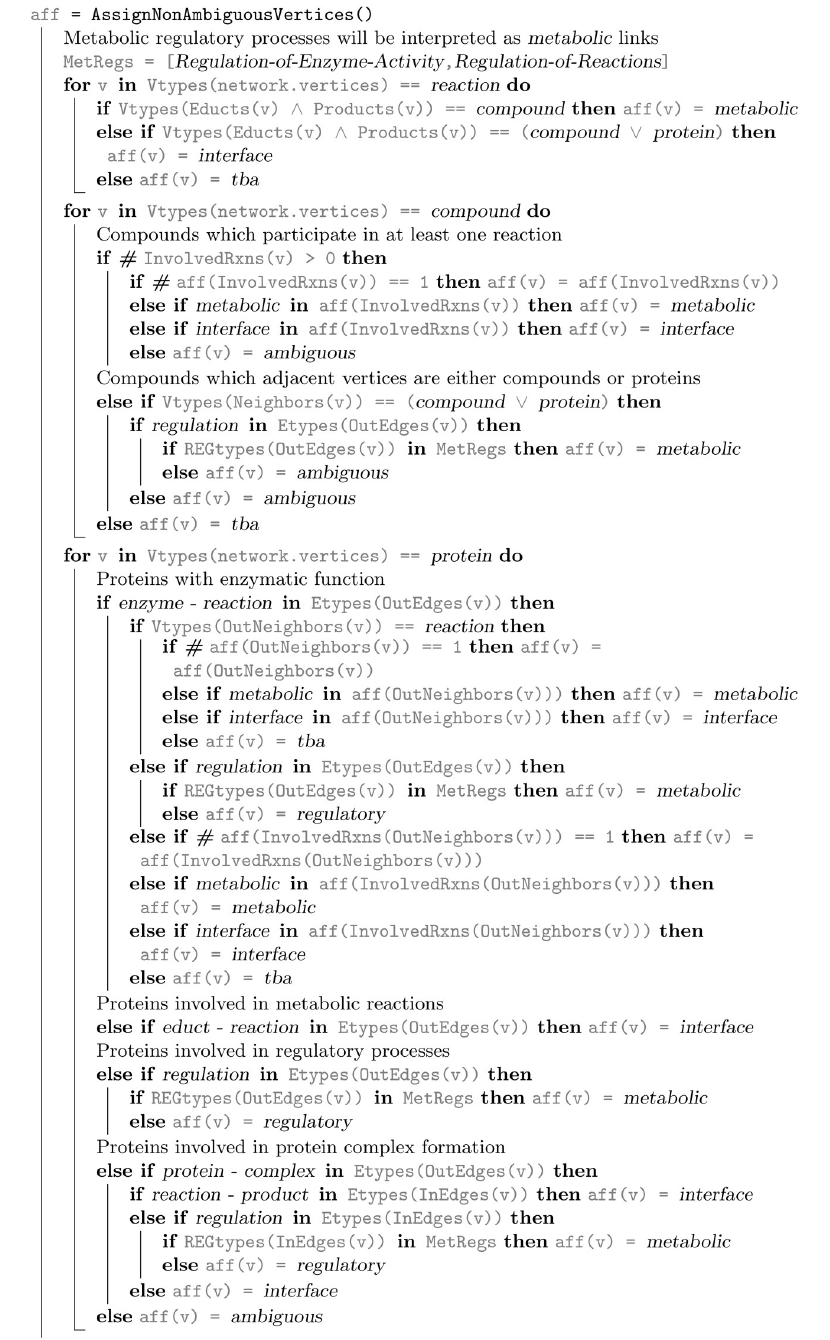
Fig 10. Algorithm 2A. Network affiliation compilation based on vertex type, and the vertex neighbors types and affiliations. Affiliation assignment for non-ambiguous reactions, compounds and proteins. Continued in Algorithm 2B in Fig